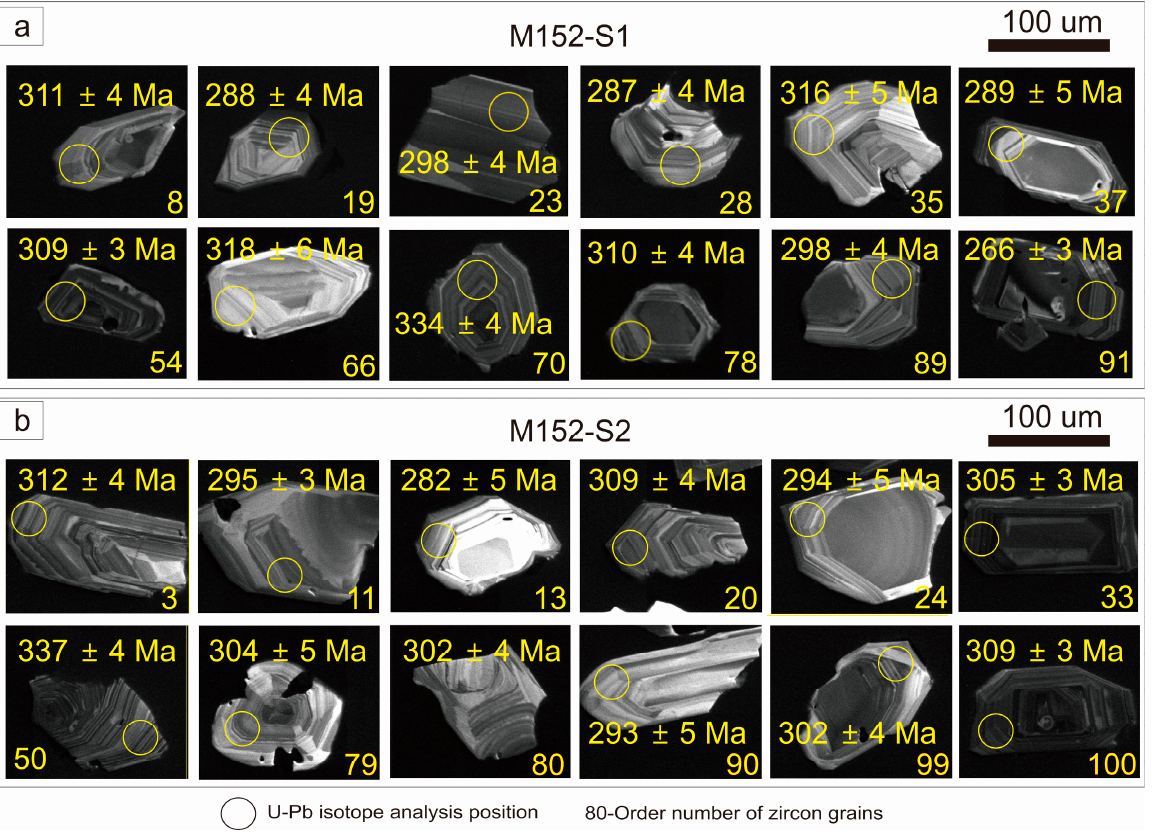
Figure 5. Cathodoluminescence (CL) images and U-Pb dates of representative detrital zircon grains from sandstone samples M152-S1 ( a ) and M152-S2 ( b ). Sample M152-S1: 91 detrital zircon grains were analyzed and 89 concordant